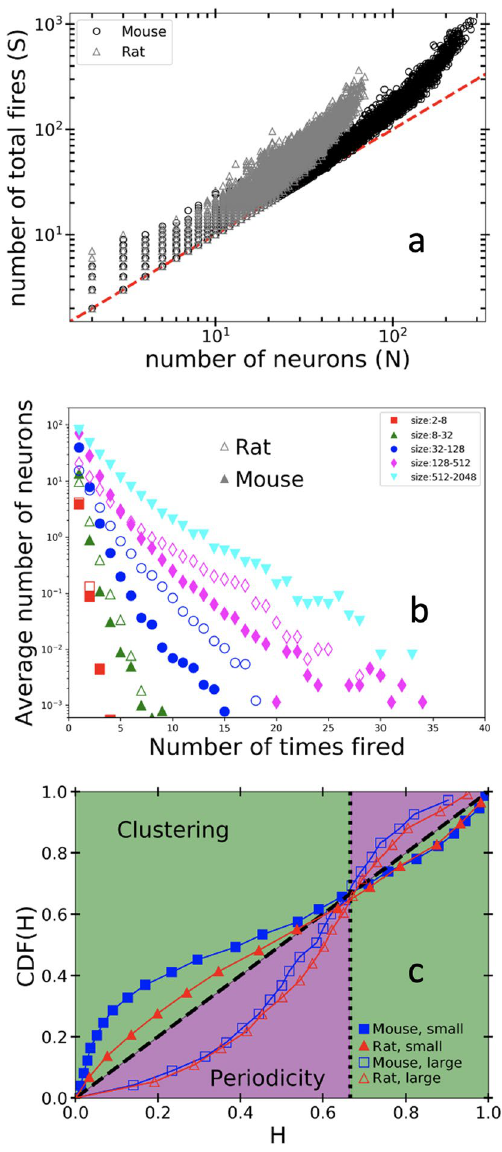
Figure 2. ( a ) Scatter-plot of avalanche size S as a function of the number of individual neurons N participating in each avalanche, as estimated by the causal-webs method 24 . For the mouse sample 434 neurons participated in 86,936 avalanches. For rat 106 neurons participated in 77,648 avalanches. ( b ) Distribution of the mean number of times each neuron fires in an avalanche, for avalanches within specified size bins. Note the rat data had no avalanches in the largest (size = 512–2048) bin. ( c ) Avalanche interevent time correlations. The � t i /(� t i �τ i / 2 ) , where (cid:31) t i is taken as the minimal interevent cumulative distribution function of H i = + fall on the dotted line. The bi-test in the green regime is a signature of temporal clustering while in the purple regime is a signature of temporal